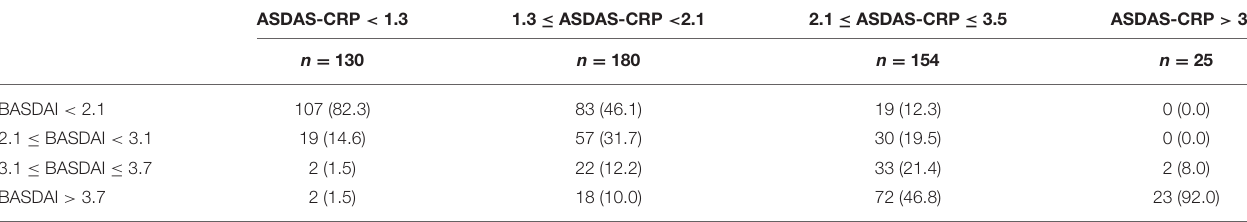
TABLE 4 | Degree of agreement between disease activity states based on BASDAI and ASDAS-CRP cut-off values. ASDAS-CRP < 1.3